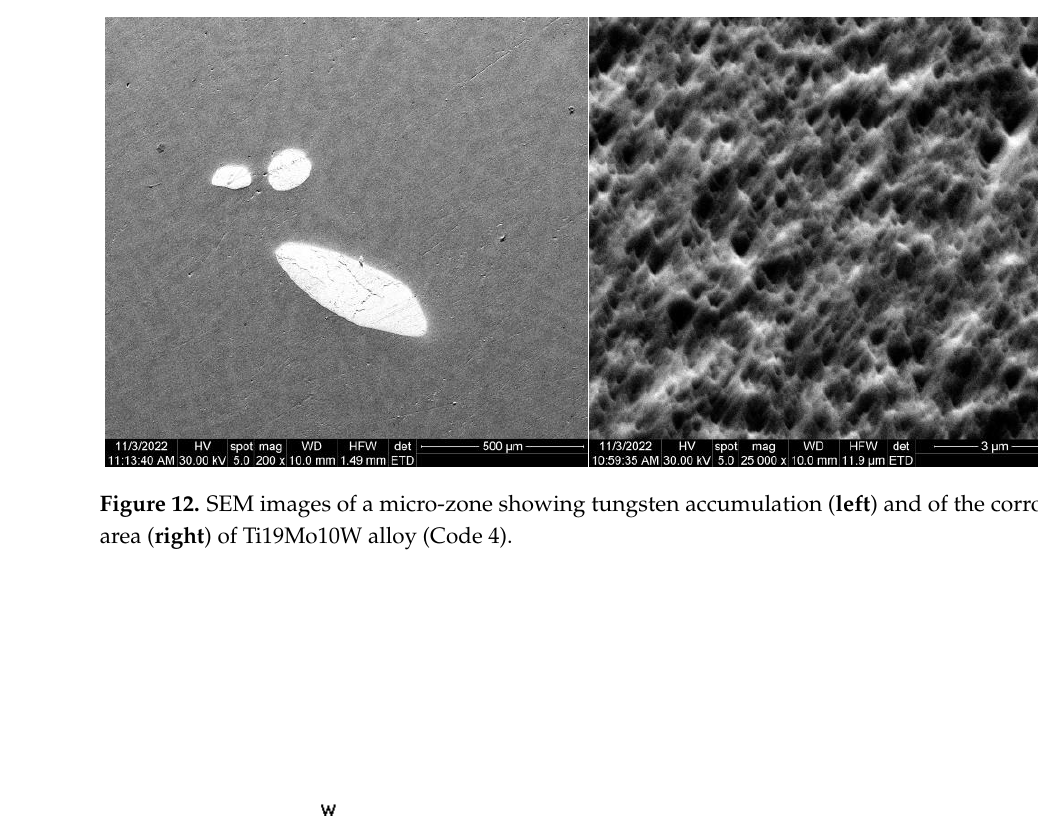
Figure 12. SEM images of a micro-zone showing tungsten accumulation ( left ) and of the corroded area ( right ) of Ti19Mo10W alloy (Code 4).